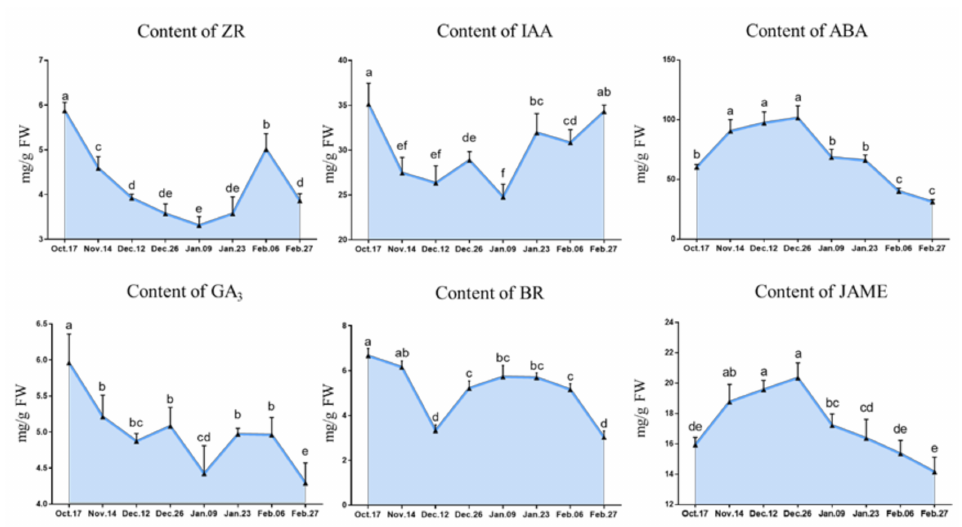
Figure 6. The changes in hormone contents during the underground bud dormancy period of ‘Meiju’. Each bar represents the mean ± SEM ( n = 3). Different letters indicate a significant difference among different dates ( p < 0.05). The experimental time was from 2018 to 2019, and the data were processed by IBM SPSS Statistics 26.